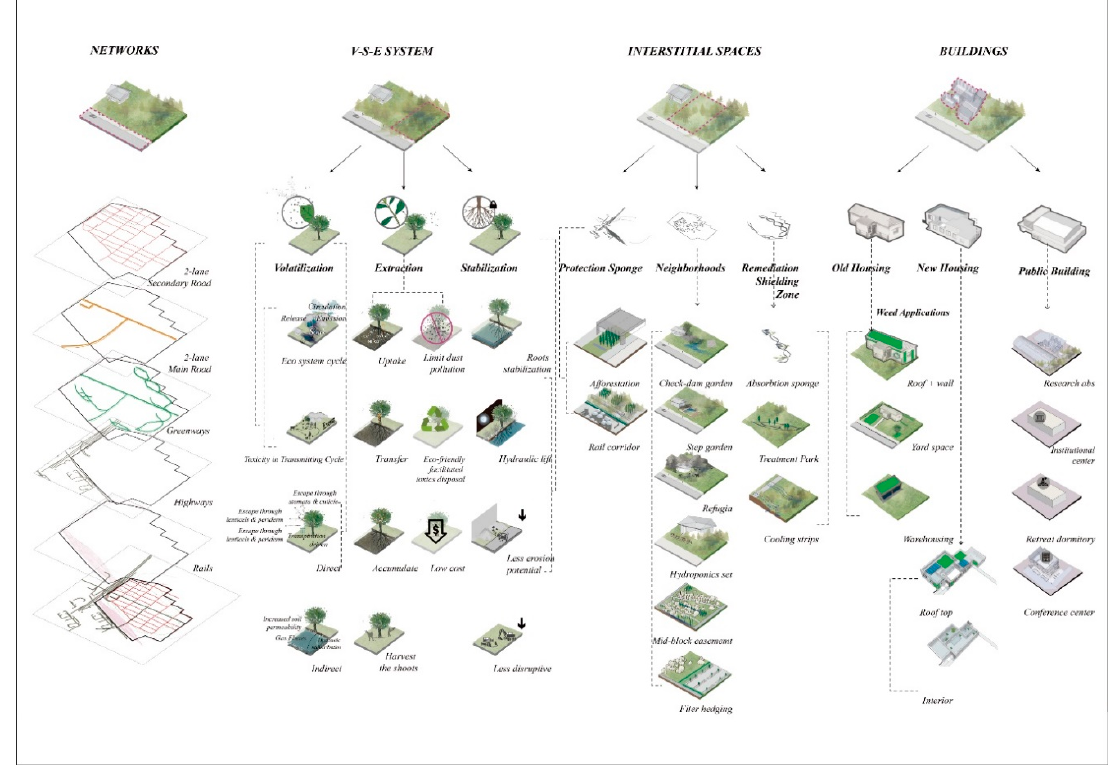
Figure 3. Schematics and program of the participatory master plan developed for Manchester, TX. Int. J. Environ. Res. Public Health 2020 , 17 , x